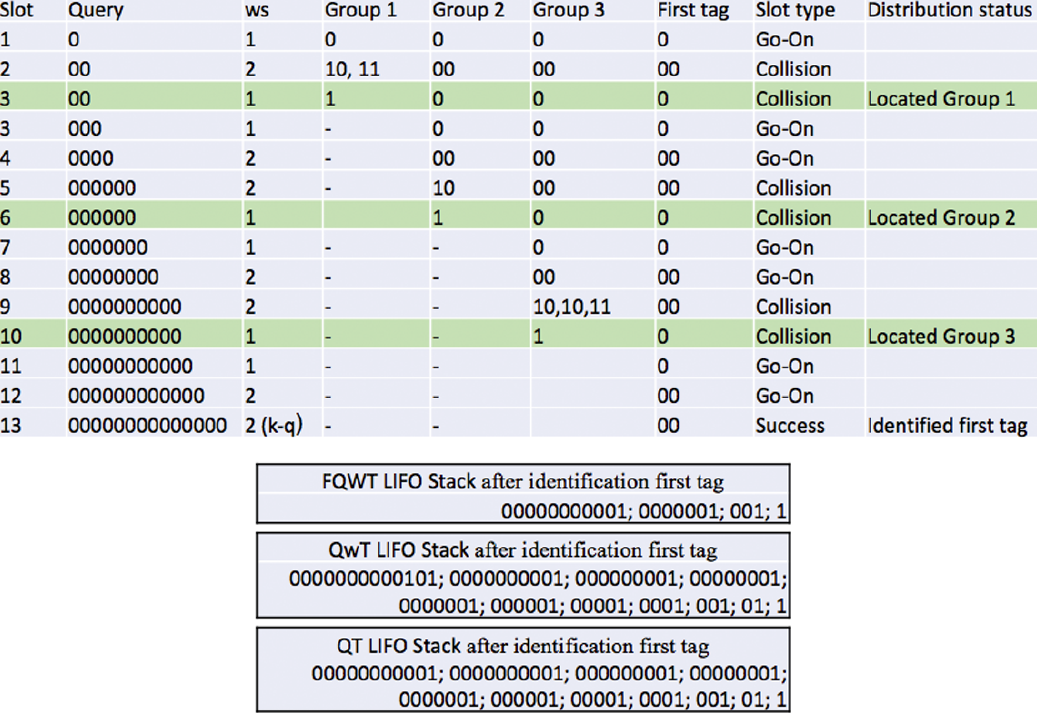
Figure 9. Comparison of FQwT, QwT, and QT protocols during the identification of the first